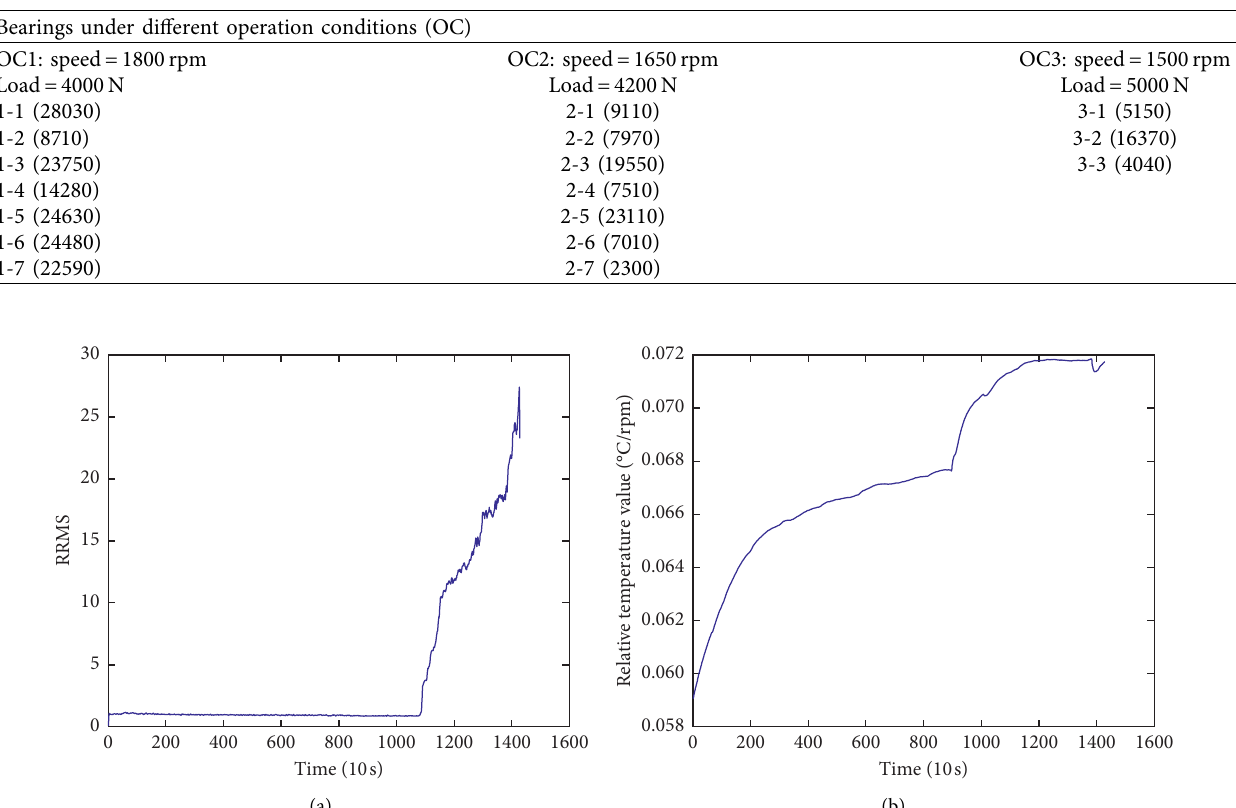
Table 1: Observed time to failure information for bearings (in seconds).